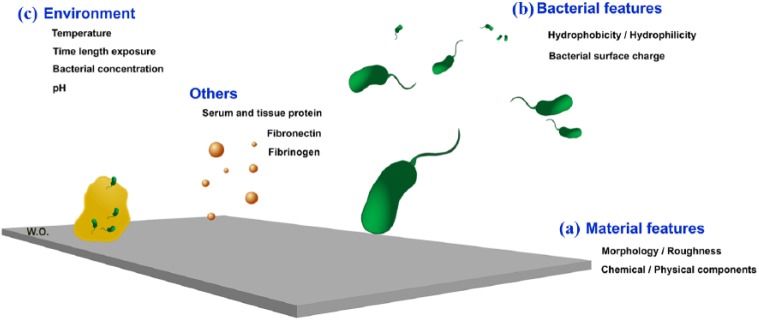
Three main features affect bacterial–material interaction. (a) Material
features such as morphology and physicochemical cues. (b) Bacterial
features including surface charge and hydrophobicity/hydrophilicity. (c)
Environments such as temperature, pH, bacterial concentration and
contact time as well as other factors such as serum and protein.